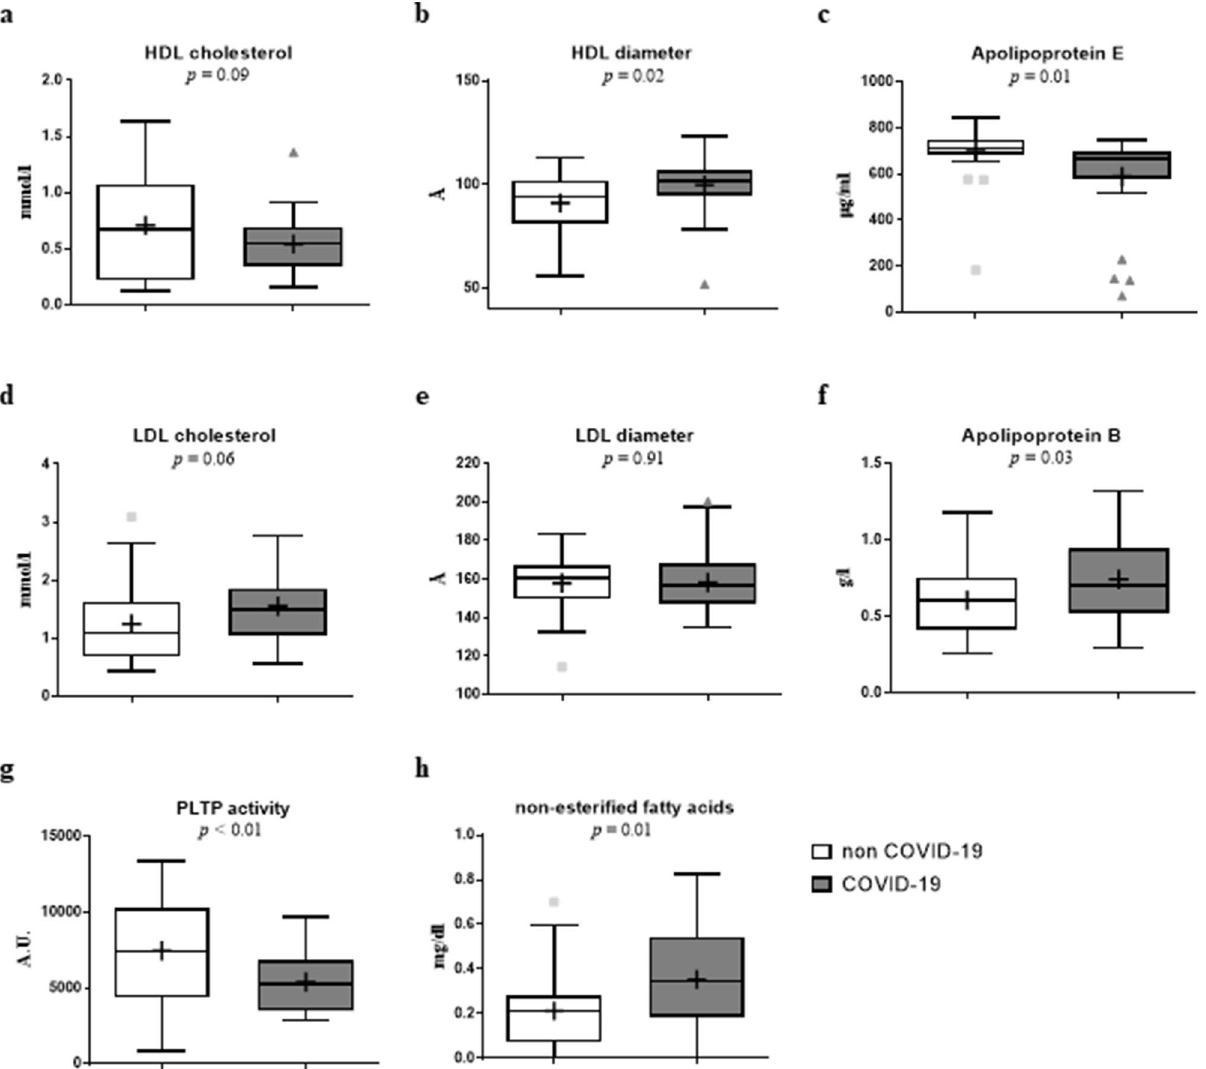
Figure 1. Boxplot representing selected lipid parameters depending on the COVID-19 status. Plasma concentration and lipoprotein diameter were measured in 34 non-COVID-19 and 27 COVID-19 patients with severe pneumonia. COVID-19 patients had significantly higher plasma concentrations of apolipoprotein B and NEFA and lower concentrations of Apolipoprotein E and phospholipid transfer protein. High density lipoprotein diameter was higher in COVID patients. HDL: High density lipoprotein; LDL: low density lipoprotein; PLTP: phospholipid transfer